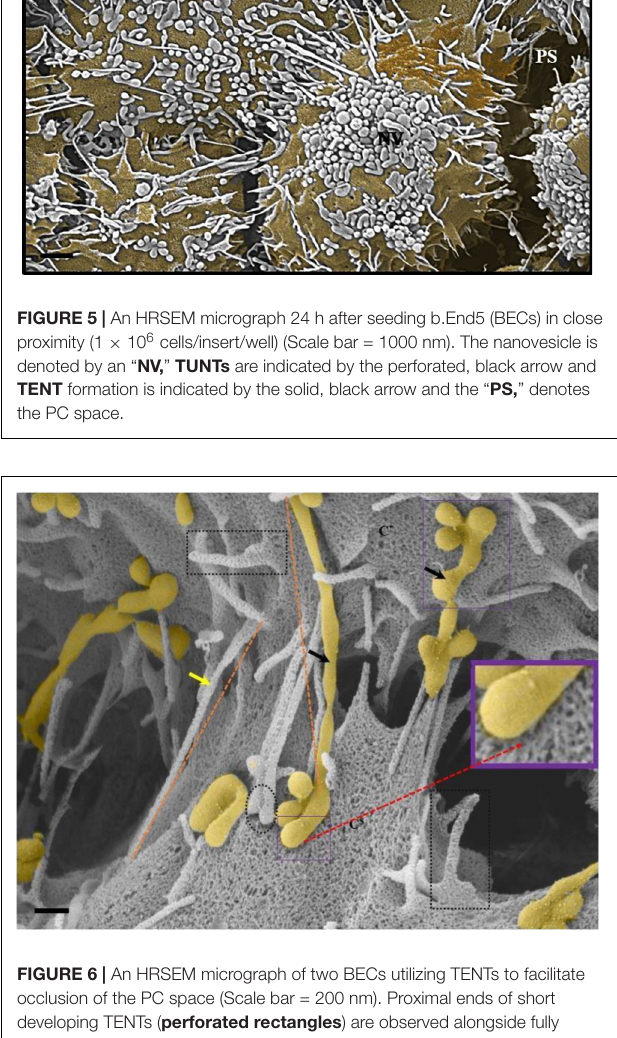
the PC spaces of adjacent BECs appearing to connect the two cells, forming a framework of tubes across the PC space of adjacent BECs.